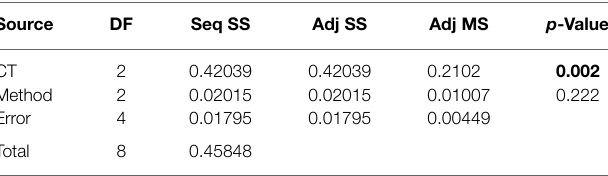
TABLE 8 | An example of analysis-of-variance table for testing the signifi- cance of CT and test method .